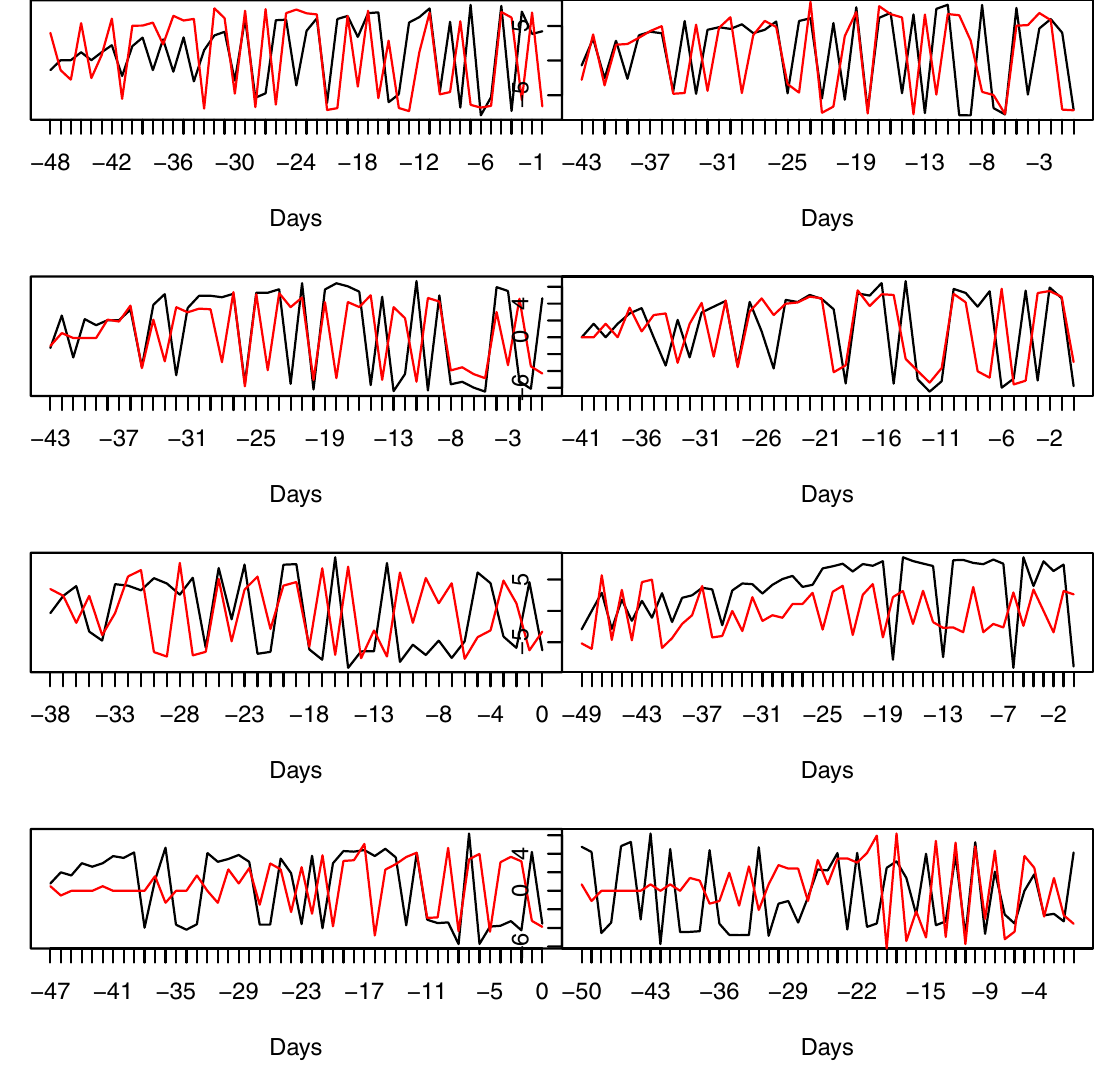
Figure 1. Number of daily cases on transformed scale for 16 countries. Left-to-right, top-to-bottom: UK, IT; FR, DE; ES, CH; BE, NL; AT, NO; US+CN; IR+CA; KR+AU. First country of pair in black, second is